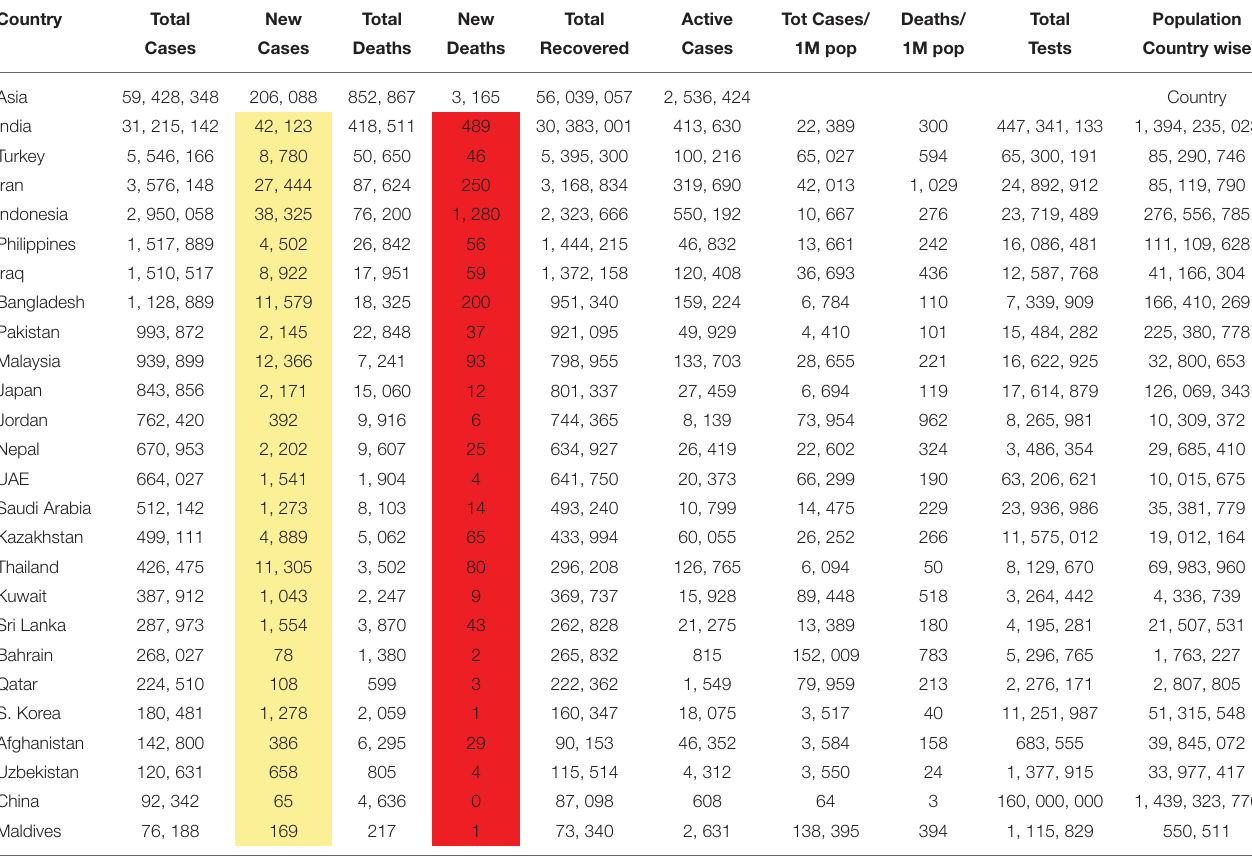
TABLE 5 | COVID-19 cases in selected Asian countries with patients victim by the virus.